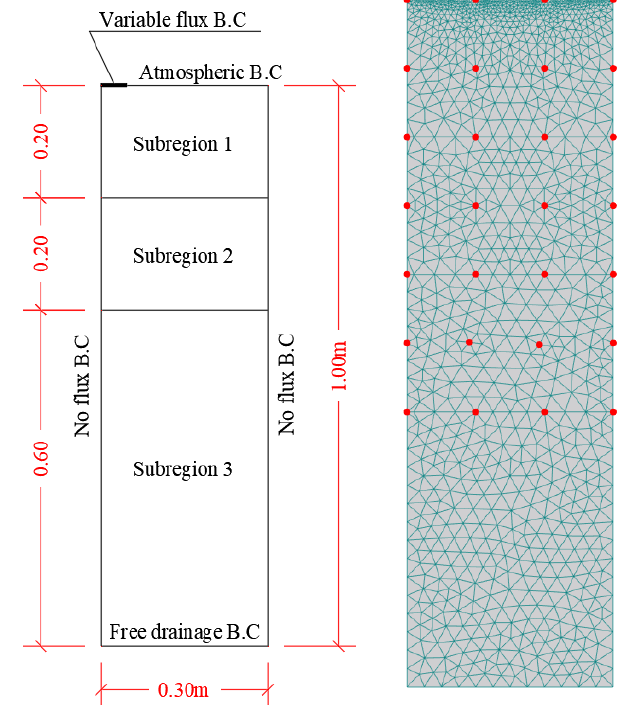
Figure 1. Domain geometry used in HYDRUS-2D simulations showing boundary conditions, variable finite element mesh generated for simulations, and location of the twenty-eight observation points.